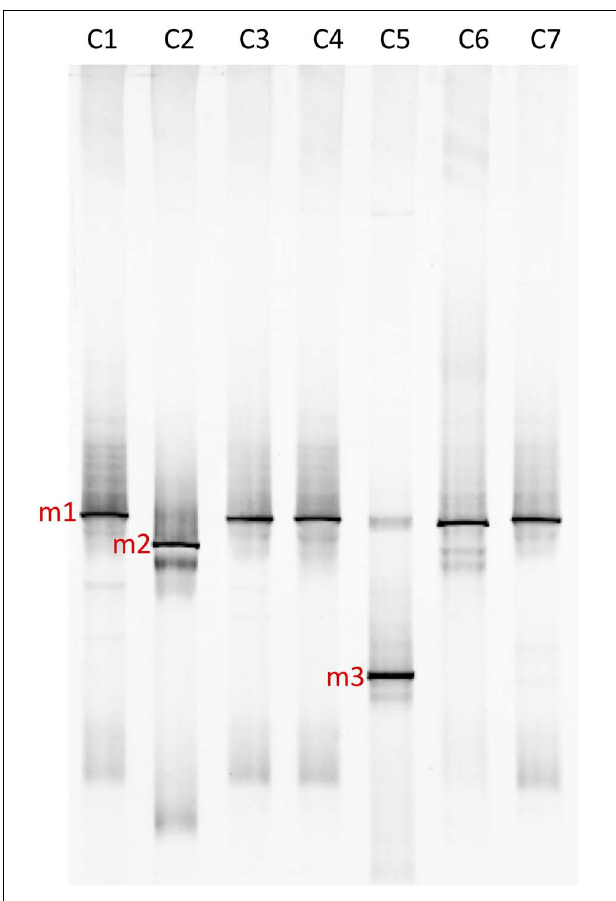
FIGURE 6 | Polymerase Chain Reaction-DGGE profile of 16S rRNA gene fragments. Bands marked on the gel were excised, PCR-amplified and identified via sequencing. Major bacterial bands (marked m1–m3) are colored in red. BLAST top hit of sequencing results suggested that the bands are closely related to the following genera (all with 99% sequence identity): m1, Glaciimonas sp.; m2, Polaromonas sp.; and m3, Actinomycetales bacterium.